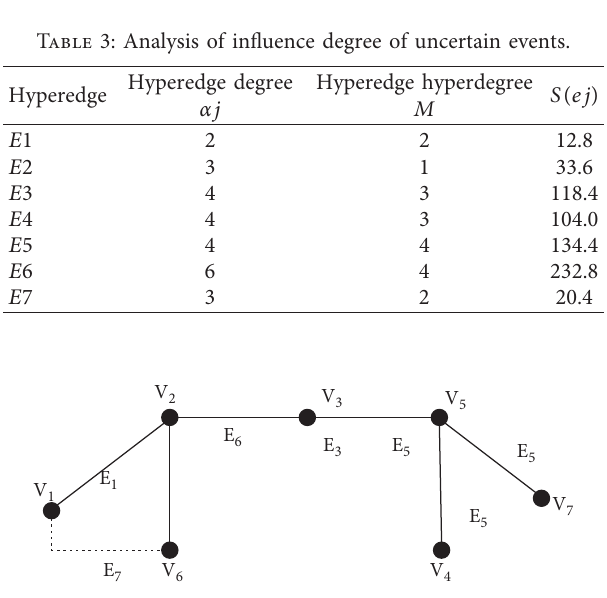
Figure 6: Chain propagation of multilevel